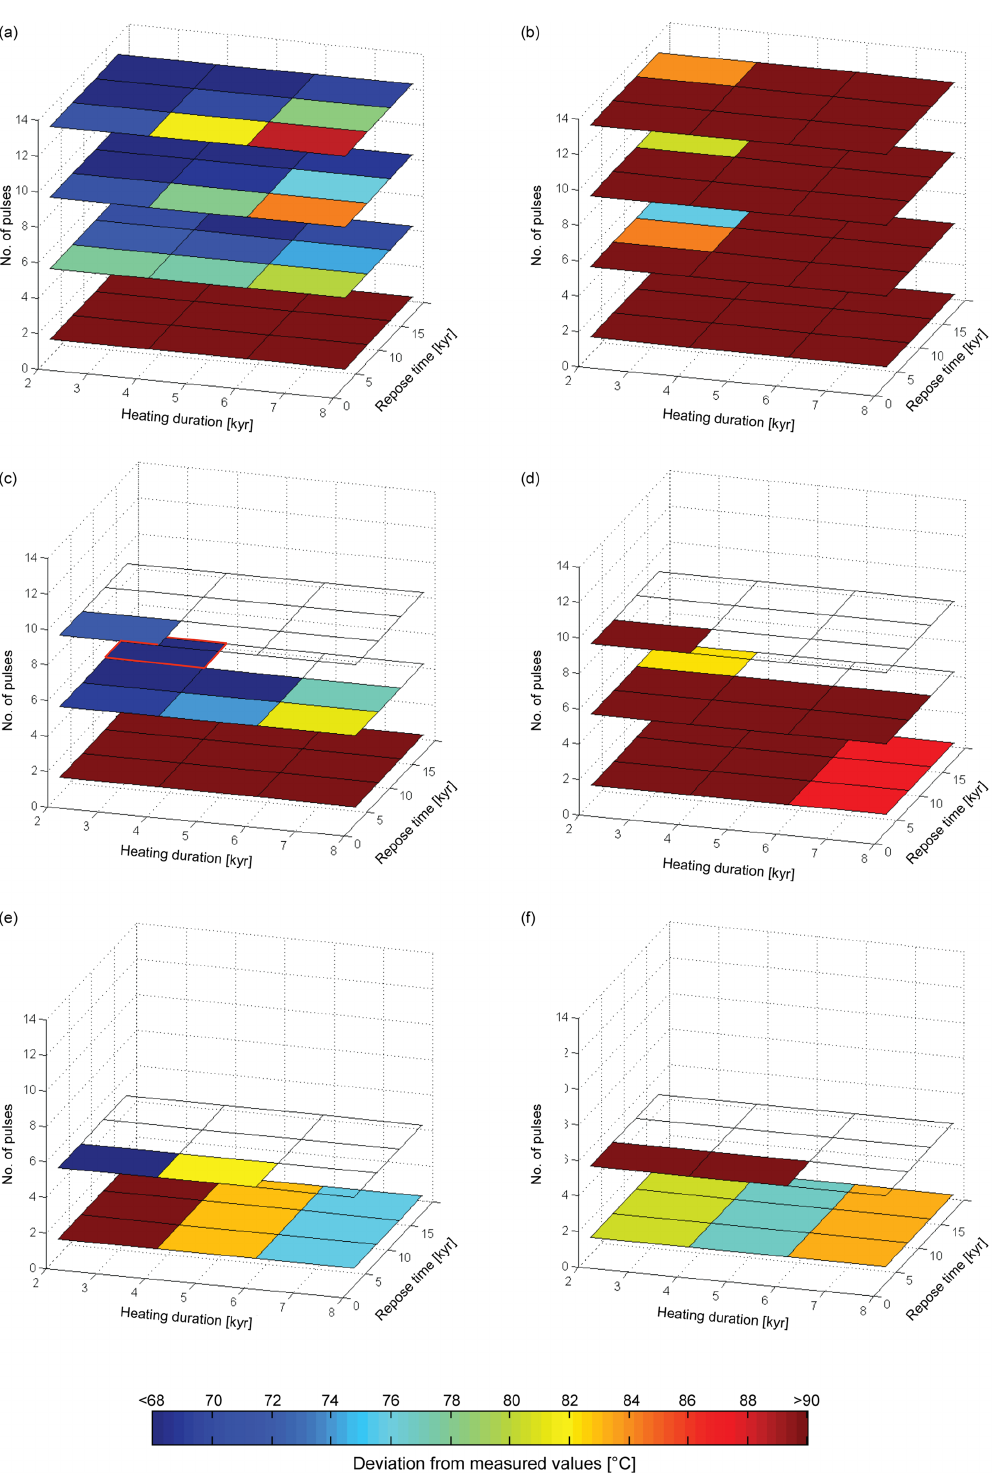
Figure 9. Optimization maps for the different model runs showing the deviation between measured and modeled temperatures in the contact aureole of the Torres del Paine intrusion. (a) One-batch model at 800 ◦ C intrusion temperature. (b) One-batch model at 1000 ◦ C intrusion temperature. (c) Two-batch model at 800 ◦ C intrusion temperature. The model providing the best fit is marked with a red margin. (d) Two- batch model at 1000 ◦ C intrusion temperature. (e) Three-batch model at 800 ◦ C intrusion temperature. (f) Three-batch model at 1000 ◦ C intrusion